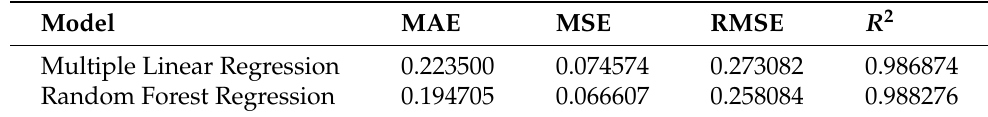
Table 6. Fitting accuracy of the regression models.